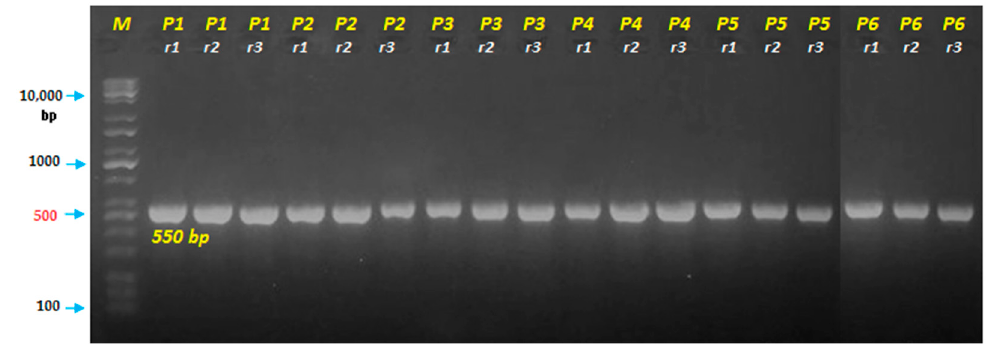
Figure 2. The amplified ITS region of the three replicates (r1 to r3) of each of the six seed lots (P1 to P6) of Conyza spp. run on 1.5% agarose